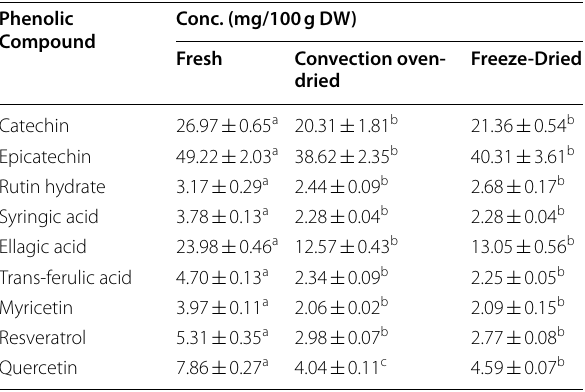
Values are expressed as mean superscripts (a-c) within a row, indicate significant differences ( p <0.05) based